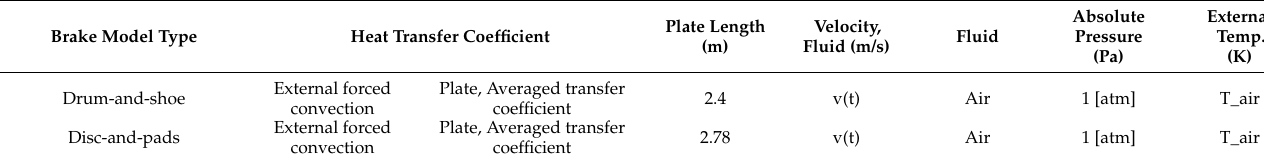
Table 2. Values and parameters for Heat Flux .